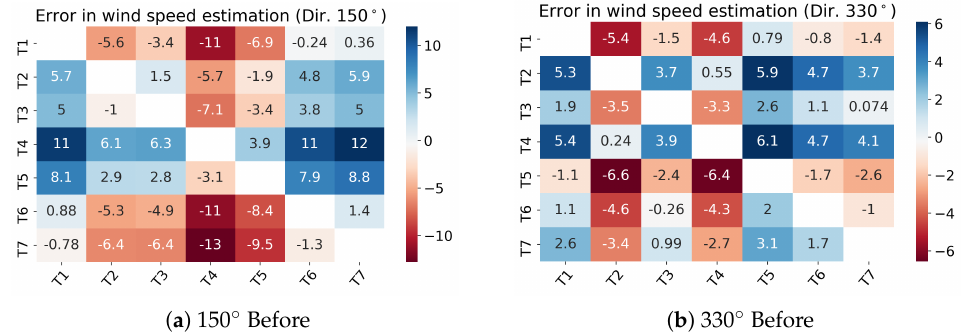
Figure 15. Percentage error in the wind speed estimation before the replacement of the T4 nacelle anemometer: low wind regime. In the i -th row, the results are obtained by calibrating the model on the nacelle wind speed of the i -th wind turbine.